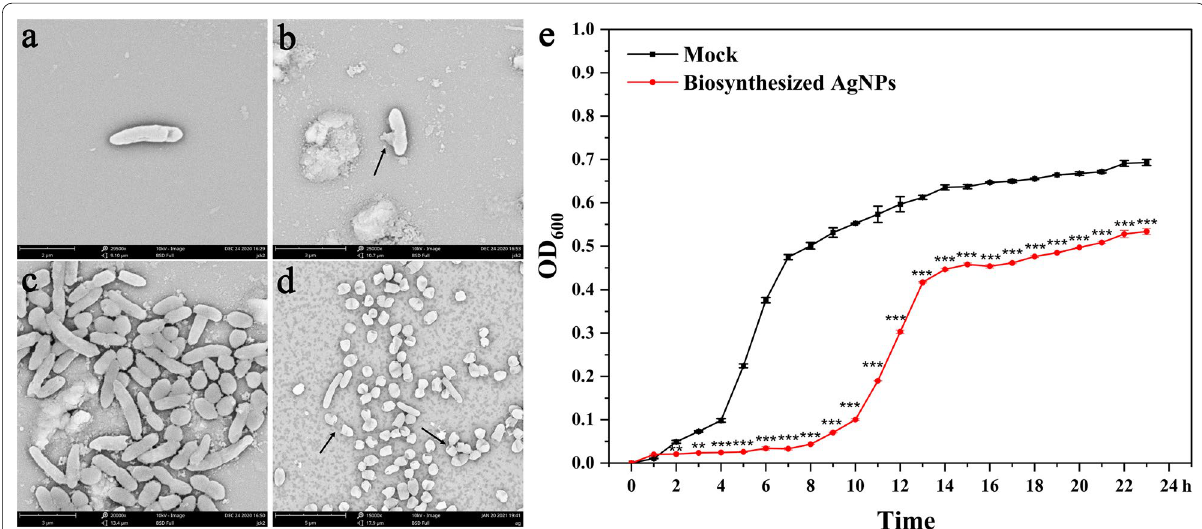
Fig. 3 Biosynthesized AgNPs destroy cell structure of Pseudomonas syringae pv. tabaci . a, c Scanning electron microscopy (SEM) images showing morphological characteristics of P. syringae pv. tabaci under normal conditions. b, d SEM images showing morphological characteristics of P. syringae pv. tabaci treated with biosynthesized AgNPs (1.2 μg/mL) for 5 h. Arrows indicate disrupted bacterial cells. e Growth curve of P. syringae pv. tabaci treated with biosynthesized AgNPs. Mock, negative control (treated with sterilized distilled water). The data are